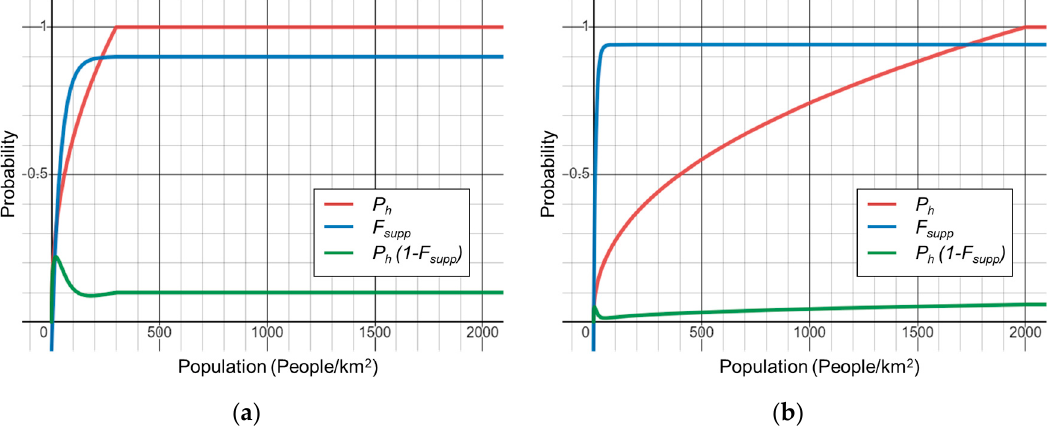
Figure 7. Optimization of the ignition probability by human factors: ( a ) original probabilities at global scale, ( b ) optimized probabilities for South Korea.